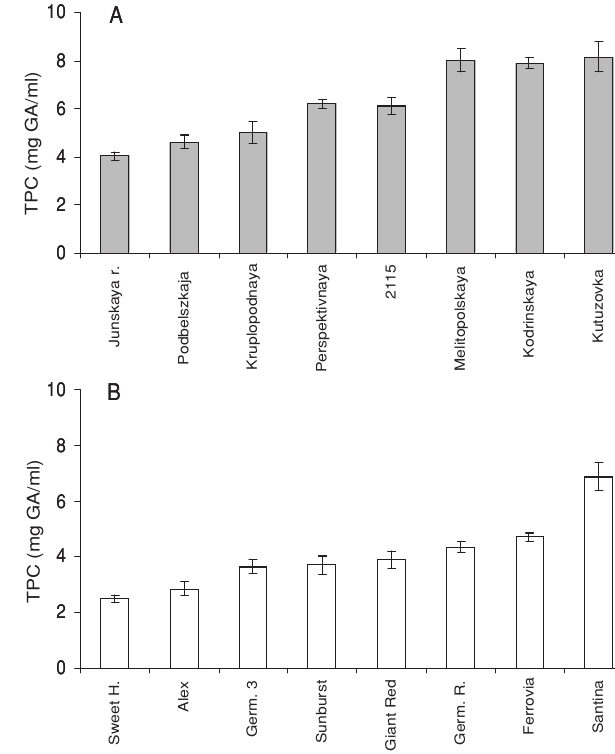
Figure 1: Antioxidant capacity of Ukrainian (A) and commercial (B) sweet cherry cultivars in 2009, Szigetcsép, Hungary